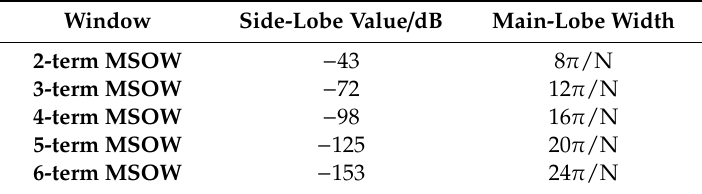
Table 3. Performance of the minimum side-lobe optimization